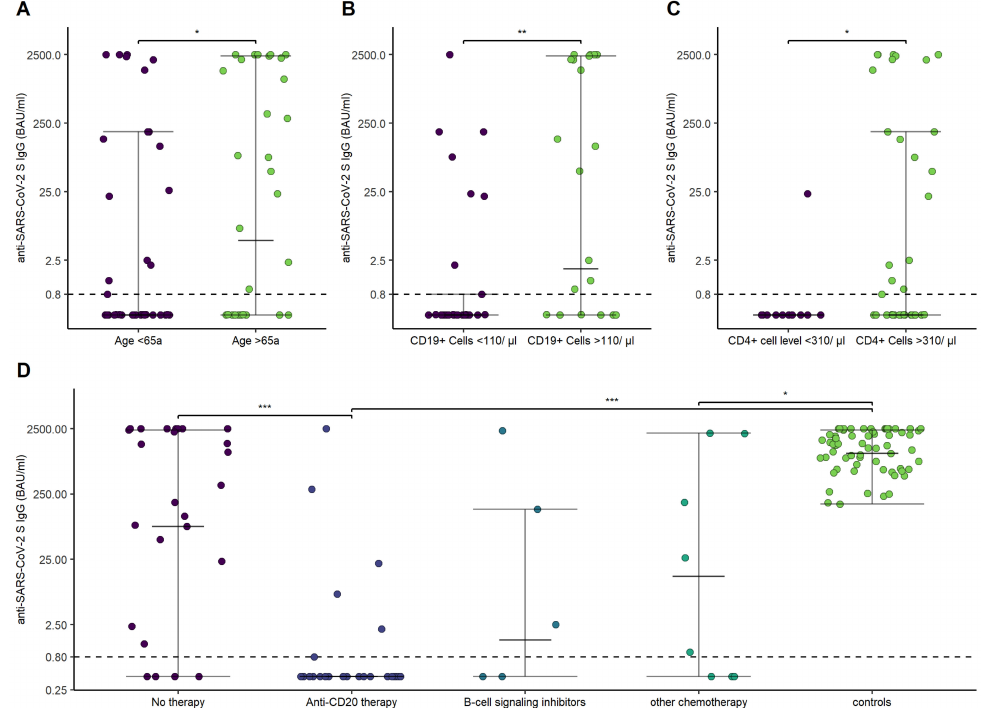
Figure 3. Anti-SARS-CoV-2 S IgG antibodies in relation to age, CD19 + B-cells and CD4 + T-cells, and different treatments. ( A ) Anti-SARS-CoV-2 S IgG in dependence of age (<65 versus >65a). ( B ) Anti- SARS-CoV-2 S IgG in dependence of CD19 + B-cell (<110/ µ L versus >110/ µ L). ( C ) Anti-SARS-CoV-2 S IgG in dependence of CD4 + T-cell levels (<310/ µ L versus >310/ µ L). ( D ) Anti-SARS-CoV-2 S IgG in dependence of treatment and compared to the control group. p -values are specified as follows: <0.05, *; <0.01, **; <0.001,